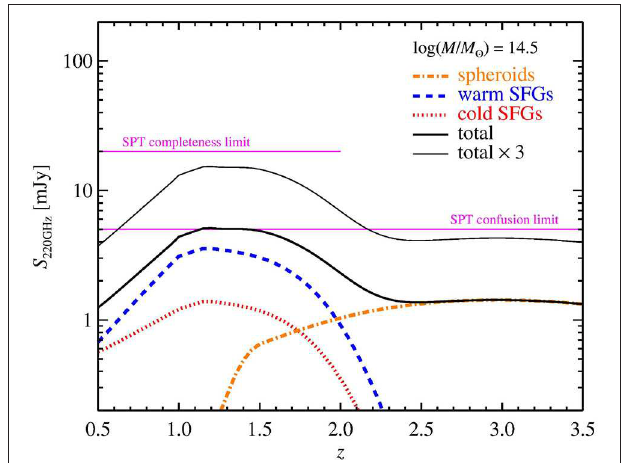
FIGURE 8 | Expected flux density at 220GHz due to the integrated dust emission from member galaxies of a cluster with M = 10 14.5 M ⊙ as a function of the cluster redshift (solid thick black curve). The cluster luminosity includes contributions from normal late-type and starburst galaxies (warm and cold SFGs, respectively) and from proto-spheroidal galaxies (spheroids), computed using the model by Cai et al. (2013). The thinner upper black curve is a factor of 3 higher and illustrates the large variance of the cluster IR emission at fixed mass (Alberts et al., 2014, 2016). It must be noted that the Planck and the SPT surveys have detected z > 0.5 clusters with masses of more that 10 15 M ⊙ . The upper horizontal line corresponds to the SPT completeness limit, the lower one to its 5 σ confusion